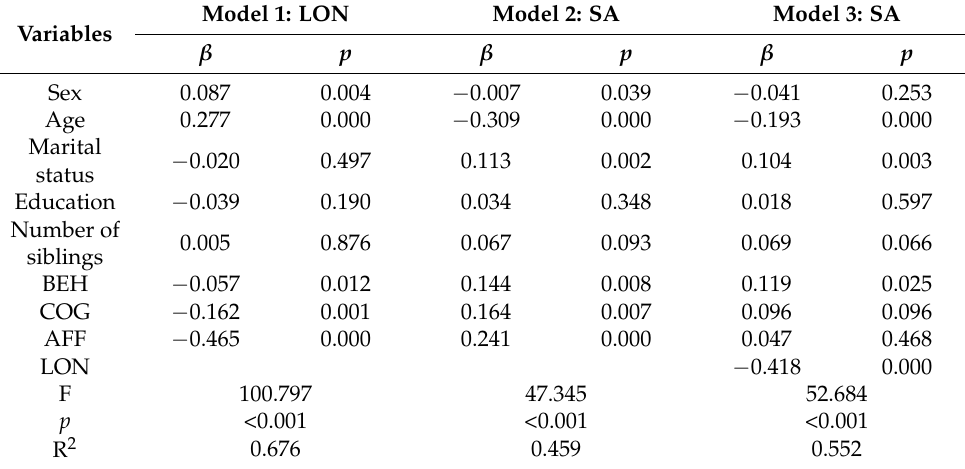
Table 3. Main regression results on loneliness and successful